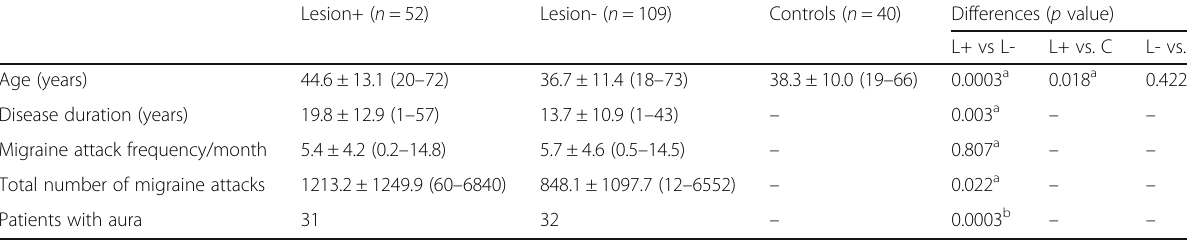
Table 1 Demographic and clinical data of migraine patients and healthy controls